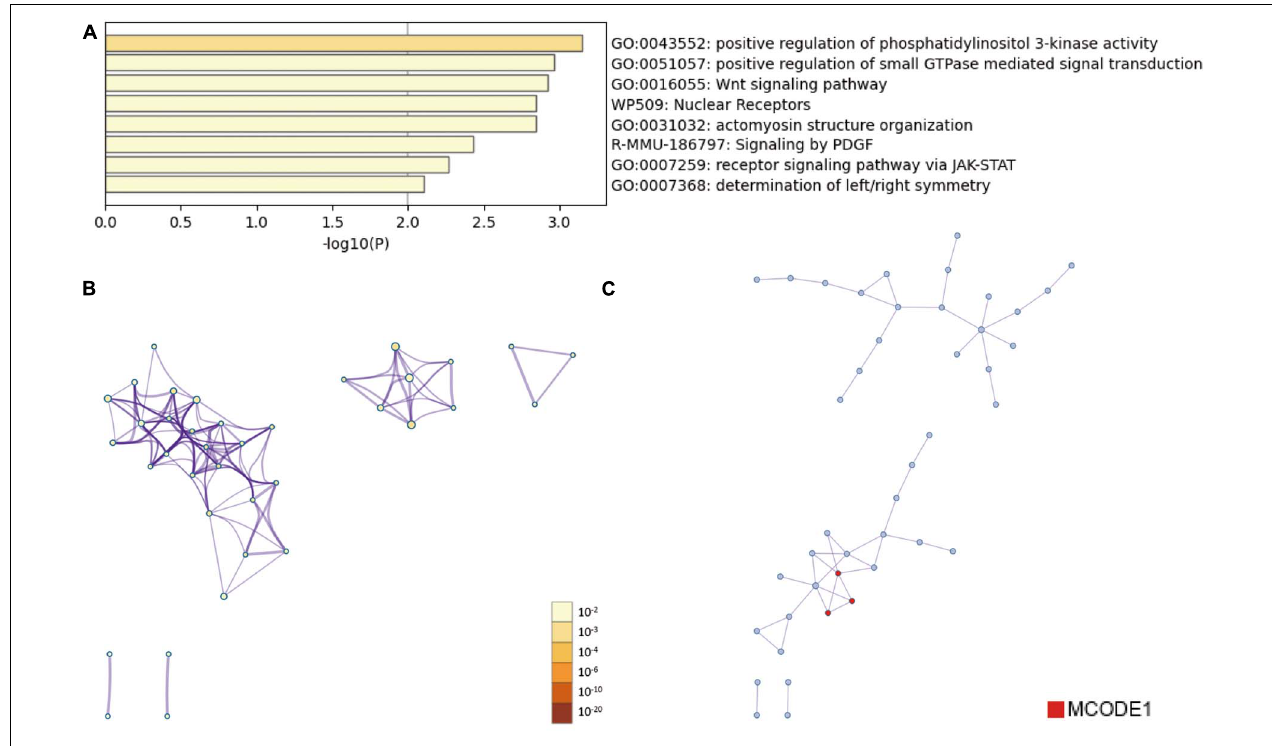
FIGURE 4 | Bioinformatic Prediction. (A) Heatmap enriched terms colored by p -values. (B) Network of enriched terms colored by p -value, where terms containing more genes tend to have a more significant p -value. (C) Protein-protein interaction (PPI) network.